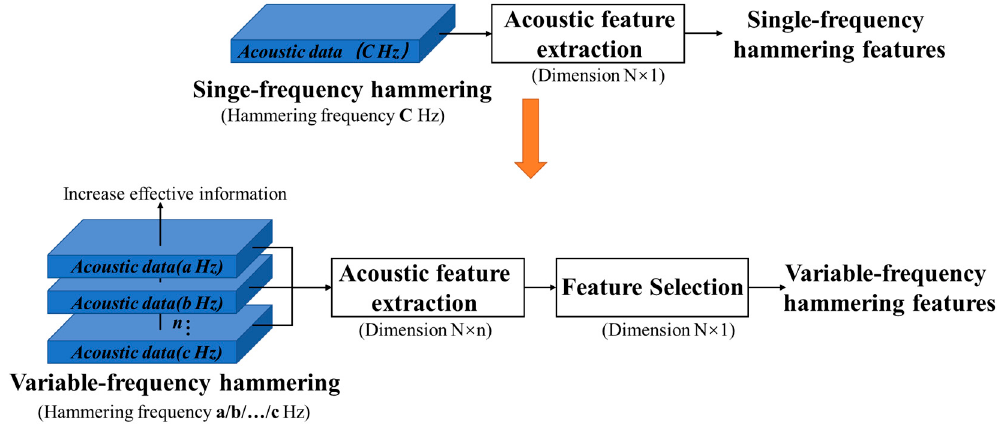
Figure 2. Diagram of the difference between variable-frequency hammering and single-frequency hammering.